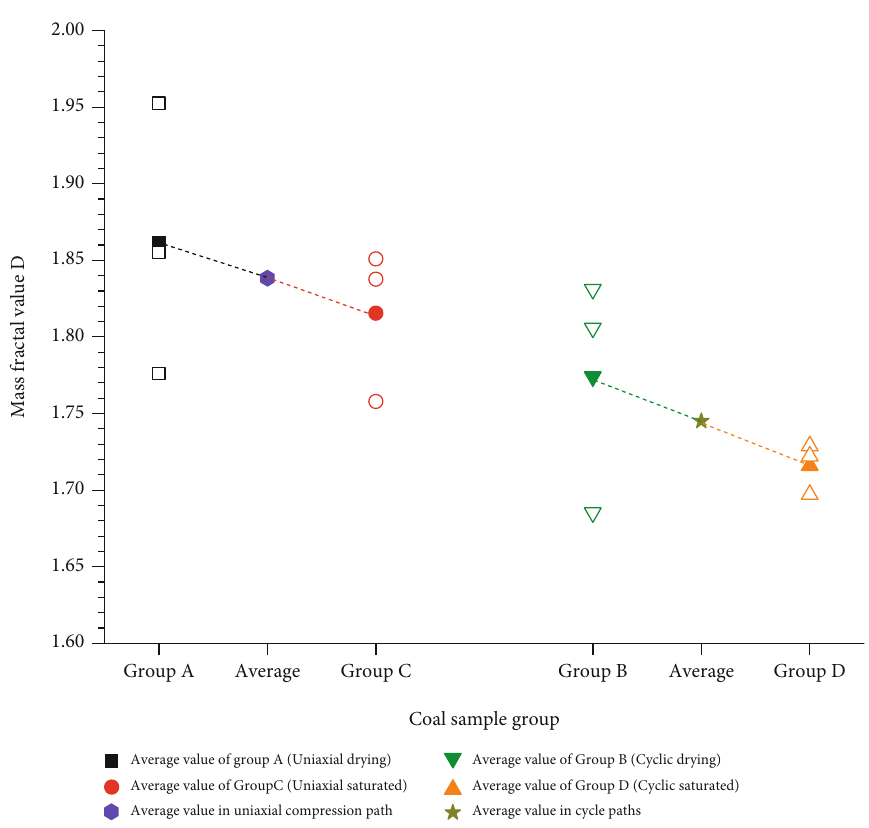
Figure 18: Mass fractal dimension distribution of coal